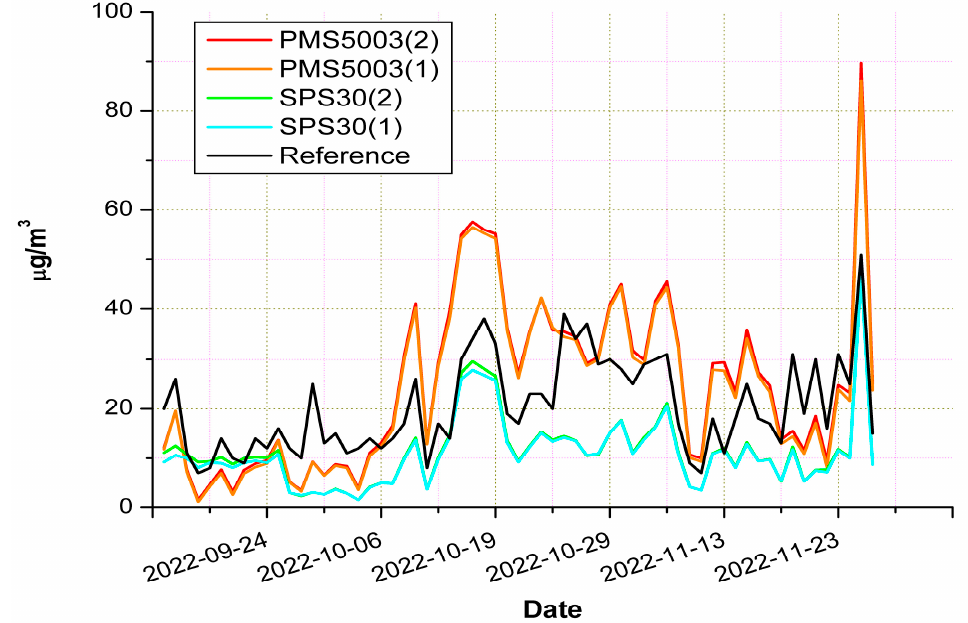
Figure 5. Time series of sensors under evaluation compared with the reference device.